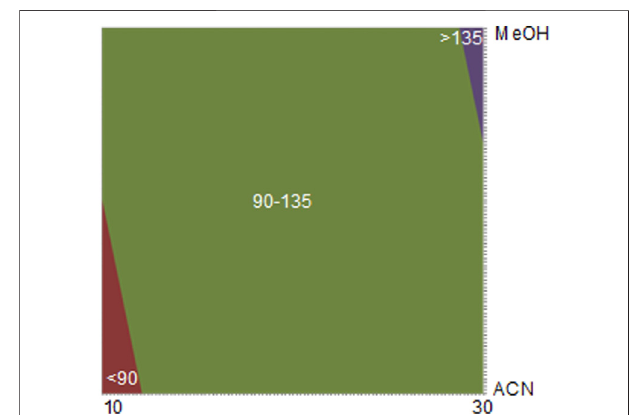
TABLE 2 | Variables used in DoE — Step 2.